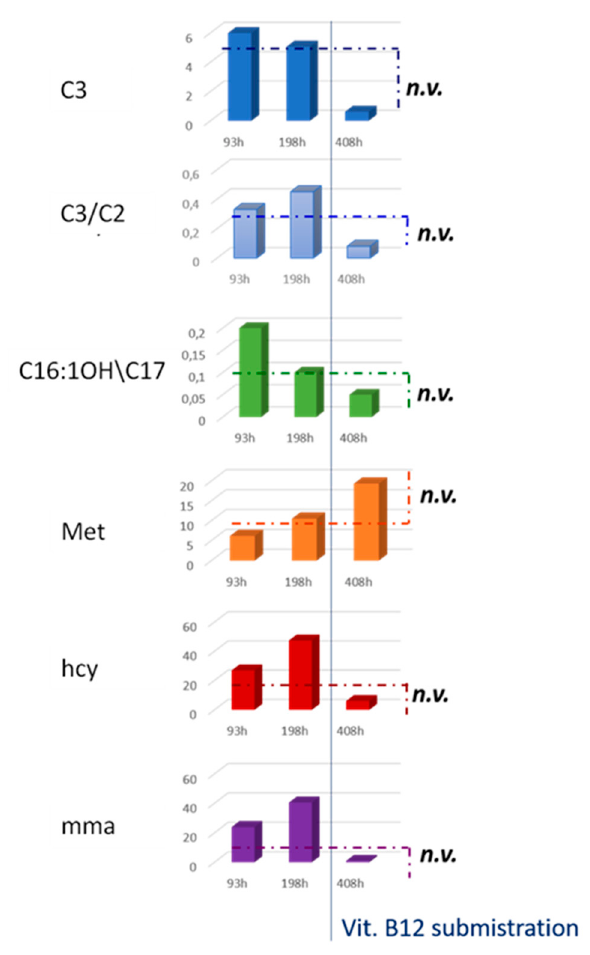
Figure 2. Histograms in the figure show the levels of C3, C3/C2, C16:OH\C17, Met, hcy, and mma from MS/MS NBS and the second-tier test of the newborn at 93, 198, and 408 h of